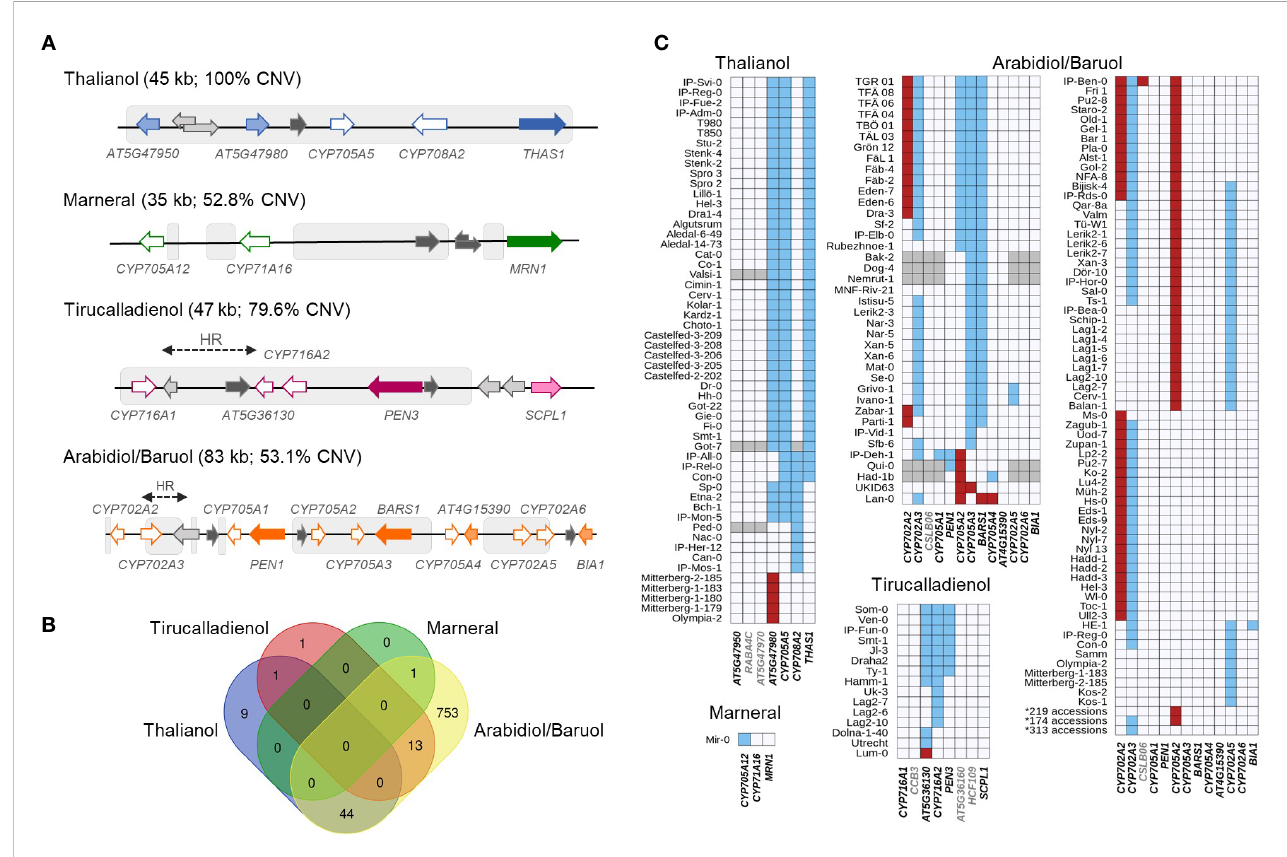
FIGURE 1 Copy number variation of Arabidopsis metabolic gene clusters. (A) MGC overlap with CNV regions. Colored arrows with white fi lling denote CYPs. Arrows with dark color fi lling denote OSCs. Arrows with light color fi lling denote other types of MGC genes. Intervening genes are in light grey. Noncoding genes are in dark grey. Grey boxes indicate overlap with CNV regions. HR – hotspot of rearrangements; (B) Number and overlap among the accessions with detected gene copy numbers in each of four MGCs; (C) Patterns of gene copy number variation in each MGC. Red – gain; blue – loss, grey – no assignment. Names of the genes considered as MGC members are in black; names of the intervening genes are in grey. Source data for histograms are in Supplemental Table